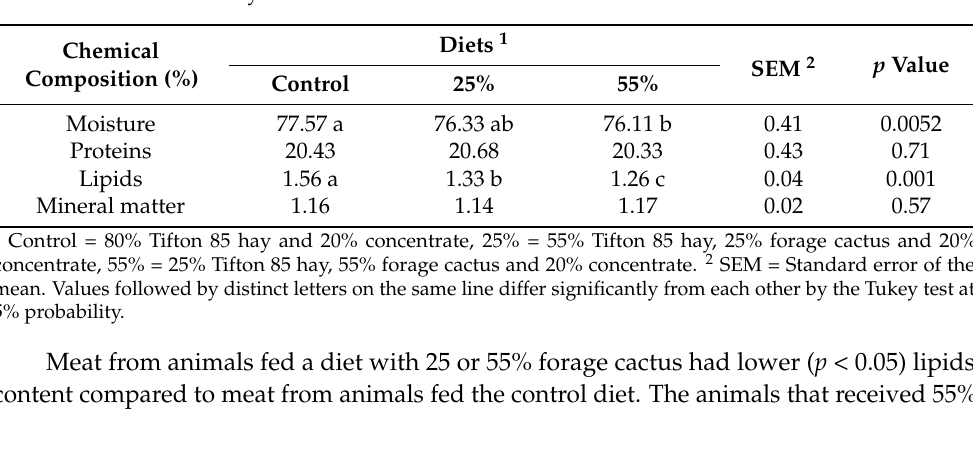
Table 4. Chemical composition of the Longissimus lumborum muscle of goats fed forage cactus as a substitute for Tifton 85